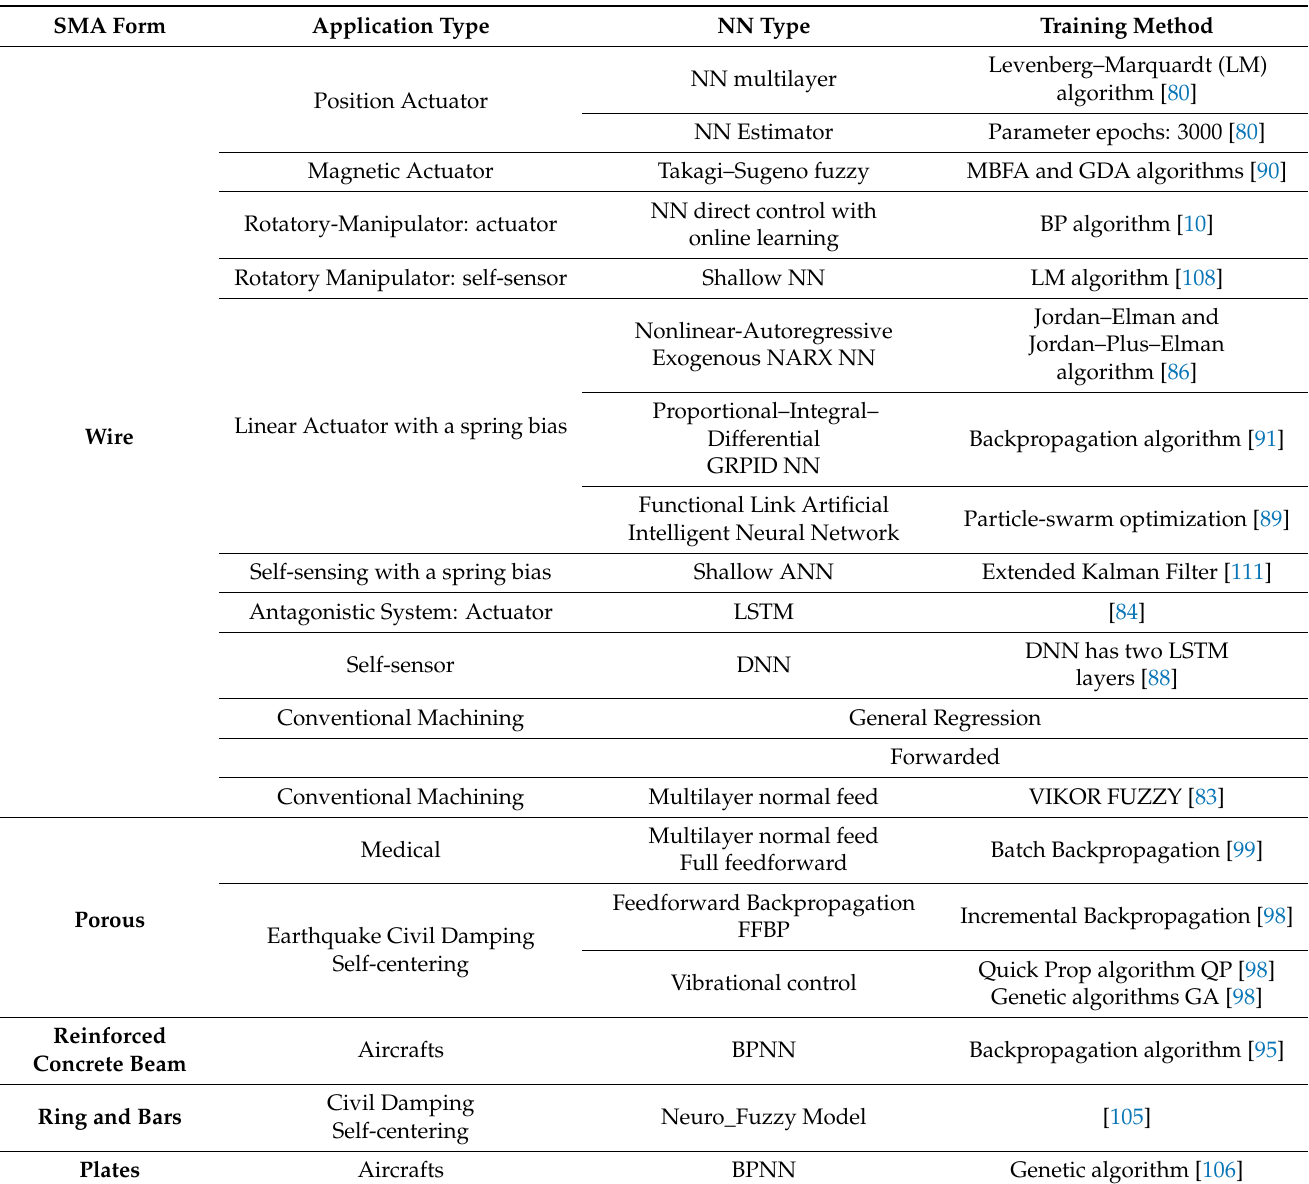
Table 3. Classification of studies as a function of SMA form and NN